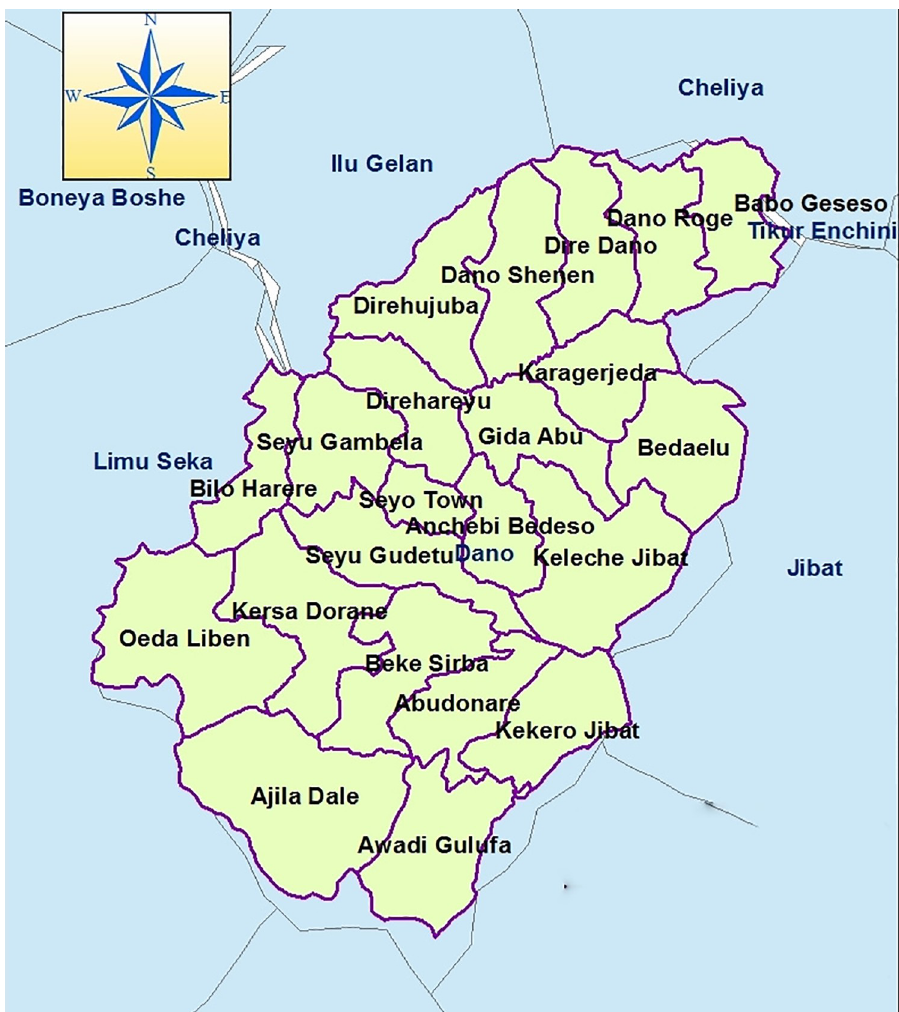
Fig 1. Map of Dano district to assess the magnitude of podoconiosis and its associated